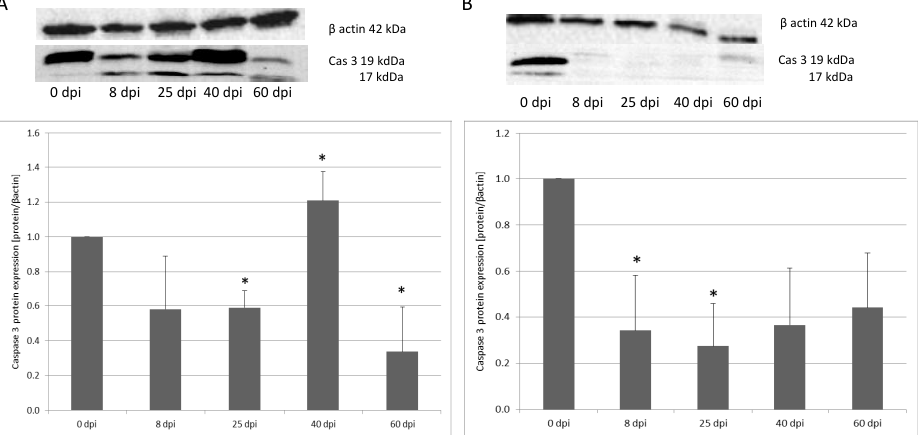
Figure 5. Representative Western blot bands and densitometric analysis of the caspase-3 protein level in the small intestine ( A ) and large intestine ( B ) from uninfected and H. diminuta -infected rats. Data represent the arithmetic mean ± SD and are representative of individual groups of six animals in each experiment. Statistical analysis was performed using the Kruskal–Wallis test, * p < 0.05 vs. 0 dpi. For caspase-9 expression in the small intestine, the highest level was observed at 60 dpi ( p < 0.05) (148%). From 8 dpi, expression was lower vs. the control. At 8 dpi, expression decreased 17%, at 25 dpi 26%, and 40 dpi 22% (not significant). Caspase-9 expression in the colon at 8 dpi was lower (42%) compared to the control group; however, the change was not significant. The level of Cas-9 protein in the colon significantly increased at 25 dpi (139%) ( p < 0.05) vs. the control, and, in subsequent groups, it decreased, reaching a significantly lower level at 60 dpi (66%). At 40 dpi, expression increased by 2% (not significant) (Figure 6).